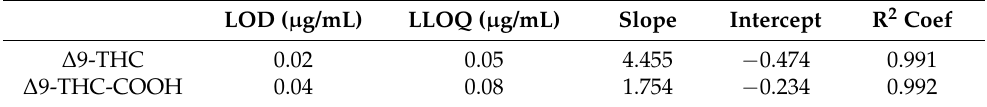
Table 1. Limit of detection, lower limit of quantitation, and calibration results for ∆ 9- THC and ∆ 9-THC-COOH in plasma.